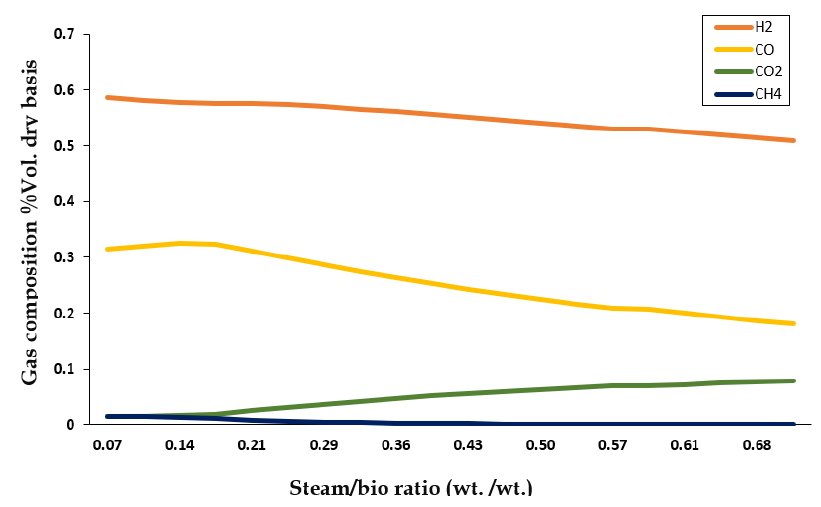
Figure 5. Effect steam-to-biomass ratio on the final composition of syngas.